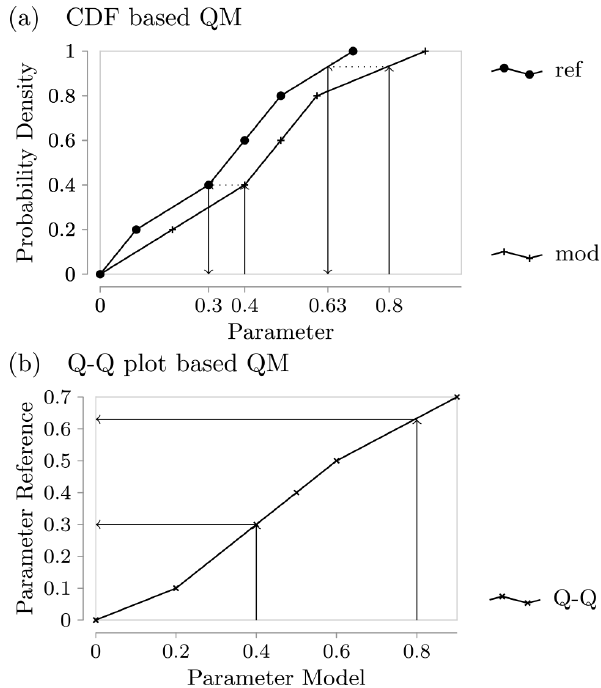
Figure 1. Illustration of the equivalence of CDF-based EQM and Q–Q-plot-based EQM. In panel (a) we plot the linear interpola- tion version of the empirical CDFs for two example data sets, while panel (b) shows the Q–Q plot that results from the same